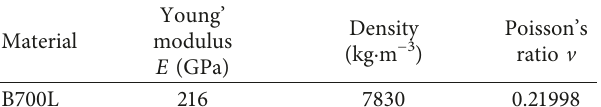
Table 2: Material elastic phase properties.